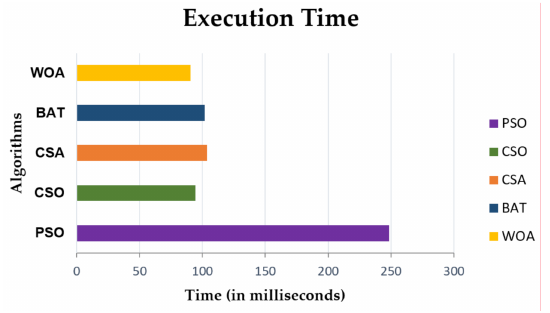
Figure 11. Comparison of execution time of PSO, CSO, CSA, BAT with